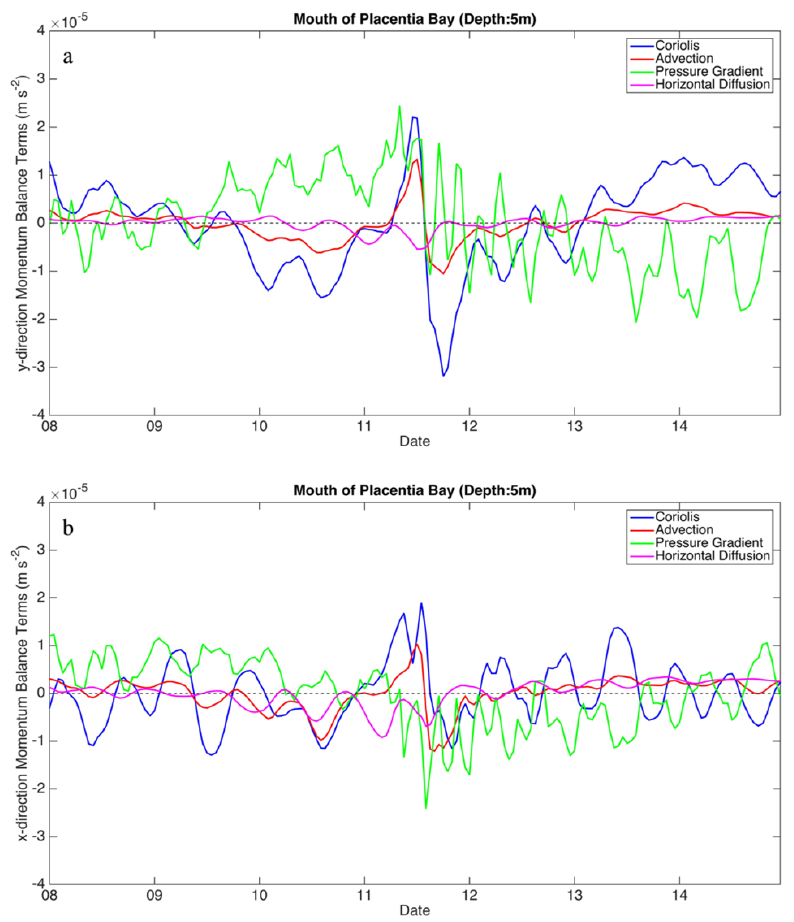
Figure 14. Anomalies of Coriolis term (blue), advection term (red), pressure gradient term (green) and horizontal diffusion term (purple) in the x-direction ( a ) and the y-direction ( b ). The root mean square (RMS) values of the Coriolis and pressure gradient terms are about four times of other terms in the x and y directions during the pre- and post-storm periods (Table 1), suggesting that the momentum balance is predominated by the Coriolis and pressure gradient terms. During the storm event (from 12:00 on 10 March to 12:00 on 12 March), the RMS values of all terms increased. The Coriolis and pressure gradient terms were about one to two times greater than the other Table 1. Root mean square values of the terms in the momentum balance at MP. (units: 10 −6 m s −2 ) 5 m During Storm 1 Before and After Storm 2